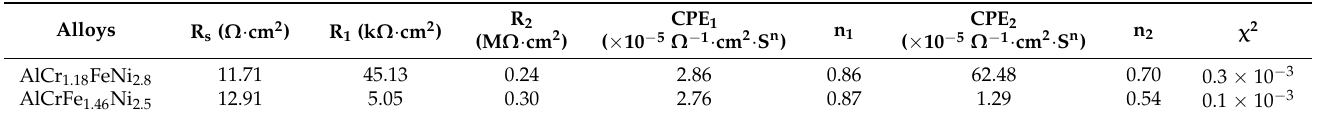
Table 5. Equivalent circuit parameters for impedance spectra of AlCr 1.18 FeNi 2.8 and AlCrFe 1.46 Ni 2.5 alloys in 3.5 wt.% NaCl